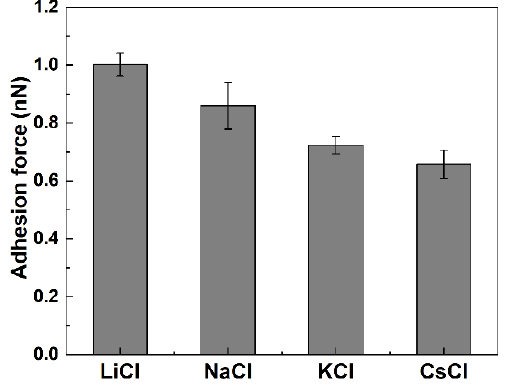
Fig. 7 Adhesion forces between PVPA-modified Ti6Al4V and PS ball in different salt solutions.